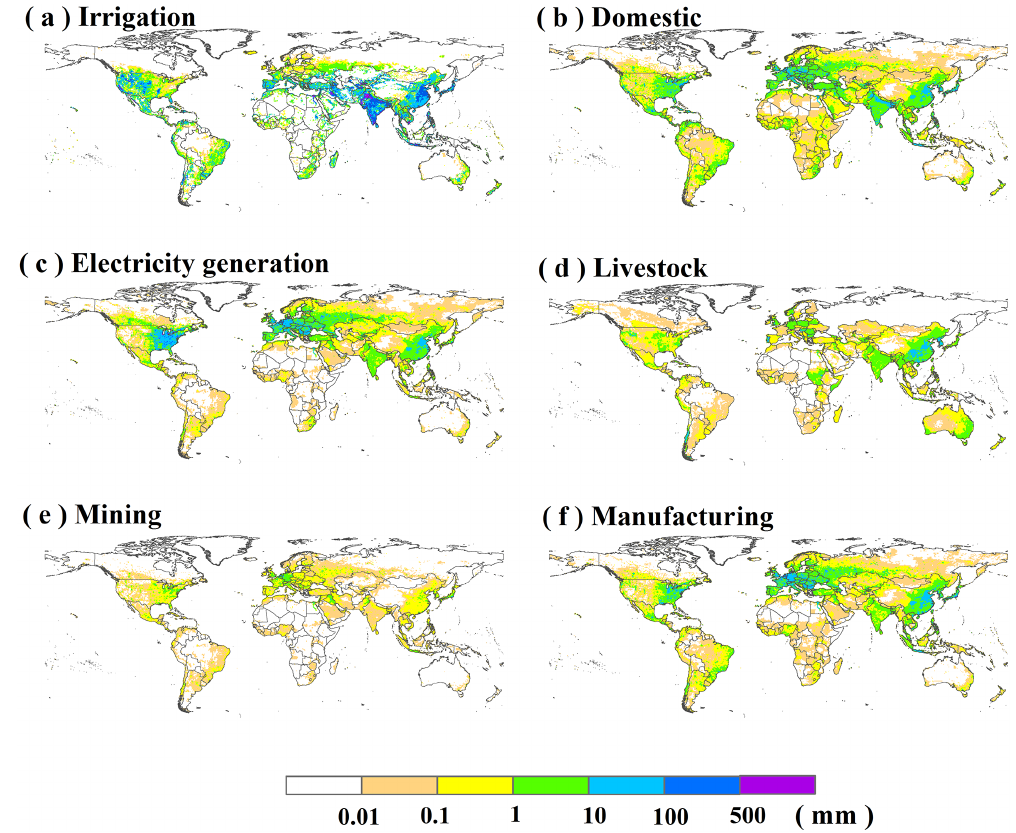
Figure 3. Spatial distribution of annual mean water withdrawal by six sectors: (a) irrigation, (b) domestic, (c) electricity generation, (d) live- stock, (e) mining, and (f) manufacturing during 1971–2010.